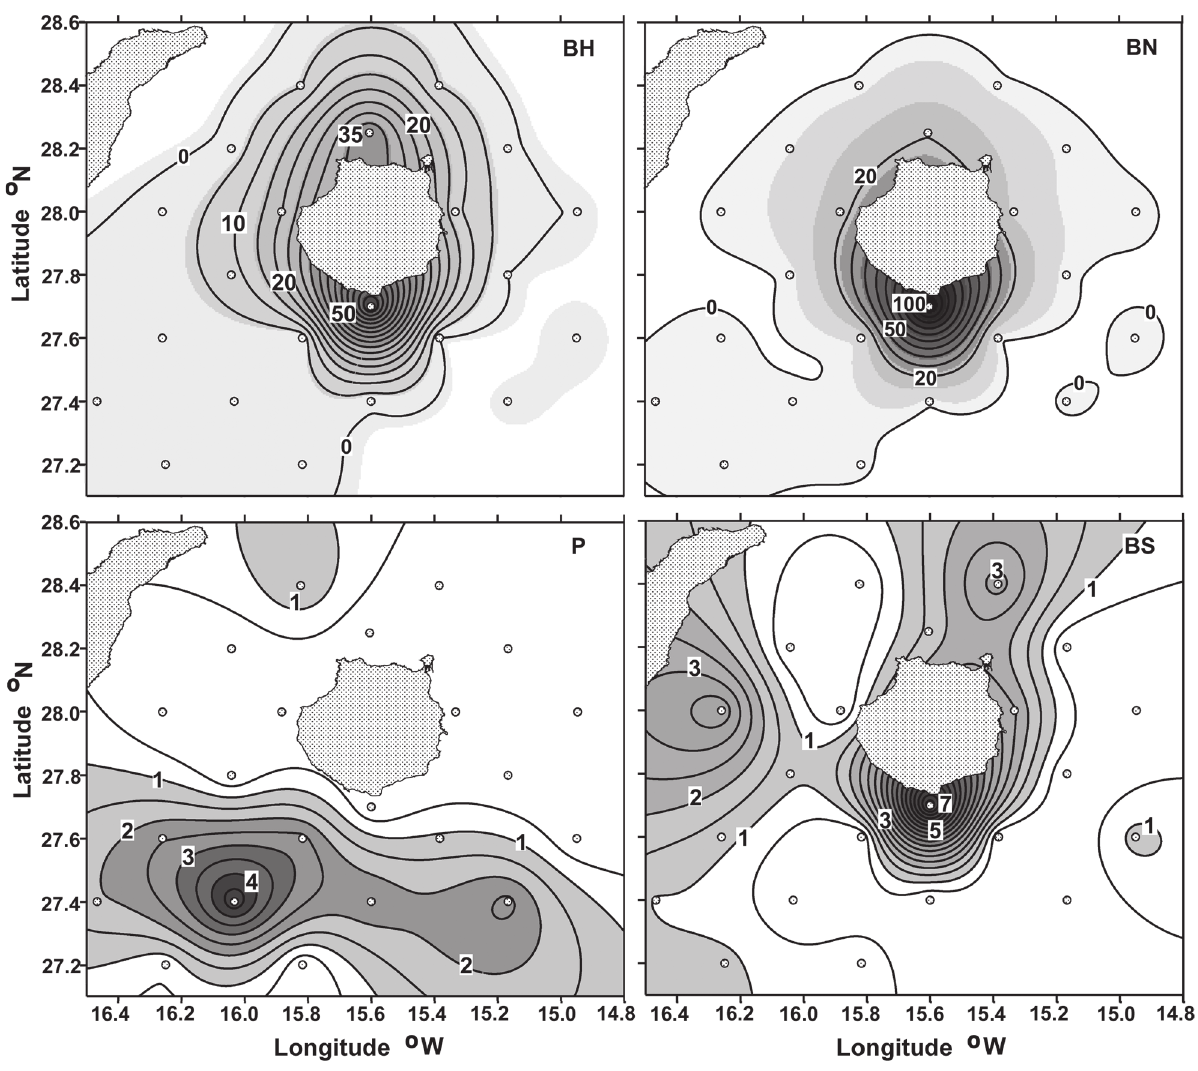
Fig . 4. – Horizontal distribution of decapod larvae abundance (larvae/100 m 3 ). BH refers to decapod larvae of benthic species with wide depth range distribution, Bn to benthic nearshore species, Bs to benthic shelf/slope species and P to larvae of pelagic species. circles refer to the sampled